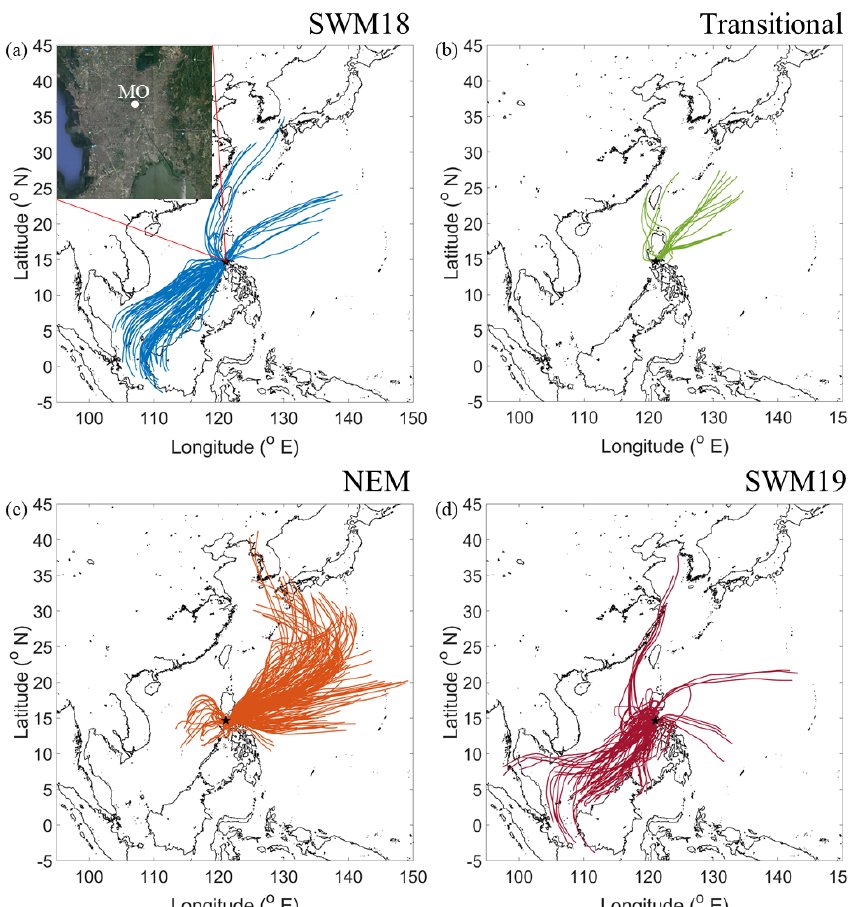
Figure 1. HYSPLIT back-trajectories for four seasons: (a) 2018 southwest monsoon (SWM18), (b) transitional period, (c) northeast monsoon (NEM), and (d) 2019 southwest monsoon (SWM19). Results shown are based on 72h back-trajectories collected every 6h during sampling periods. The top left corner of (a) zooms in on Metro Manila, with Manila Observatory (MO) marked. The black star in each panel represents the sampling site. Map data: © Google Earth, Maxar Technologies, CNES/Airbus, Data SIO, NOAA, U.S. Navy, NGA,